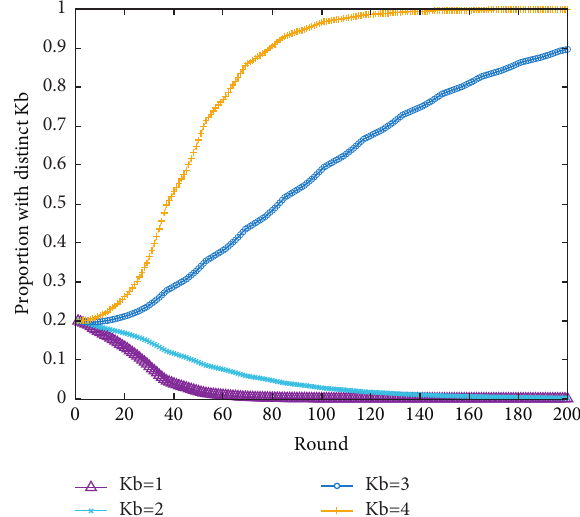
Figure 3: Influence on behavior with distinct K